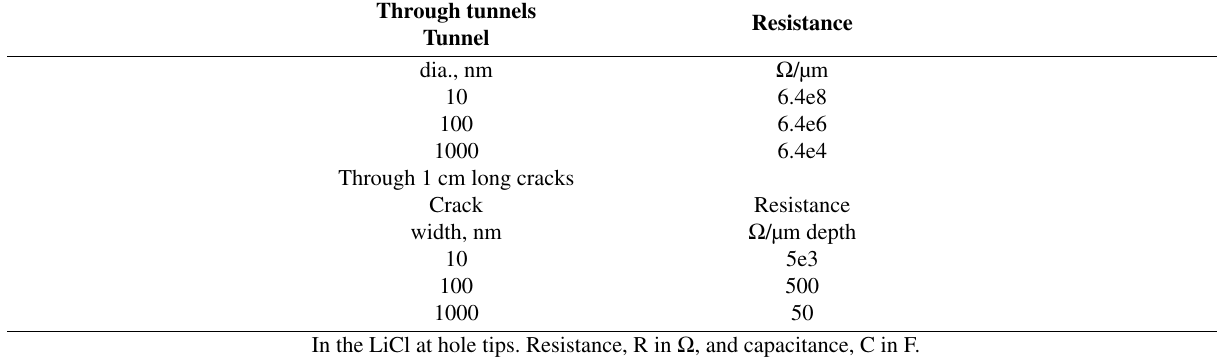
/SOCl -catholyte and of the solid 4 2